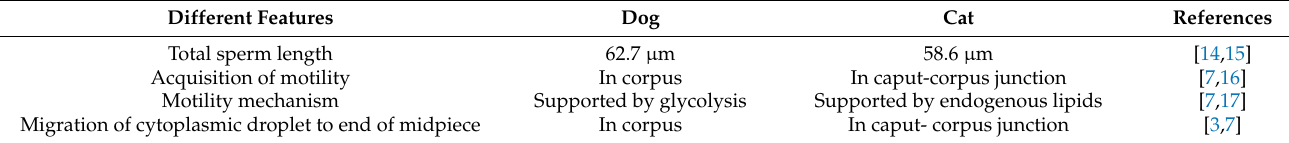
Table 1. Different features in epididymal sperm maturation in dogs and cats.